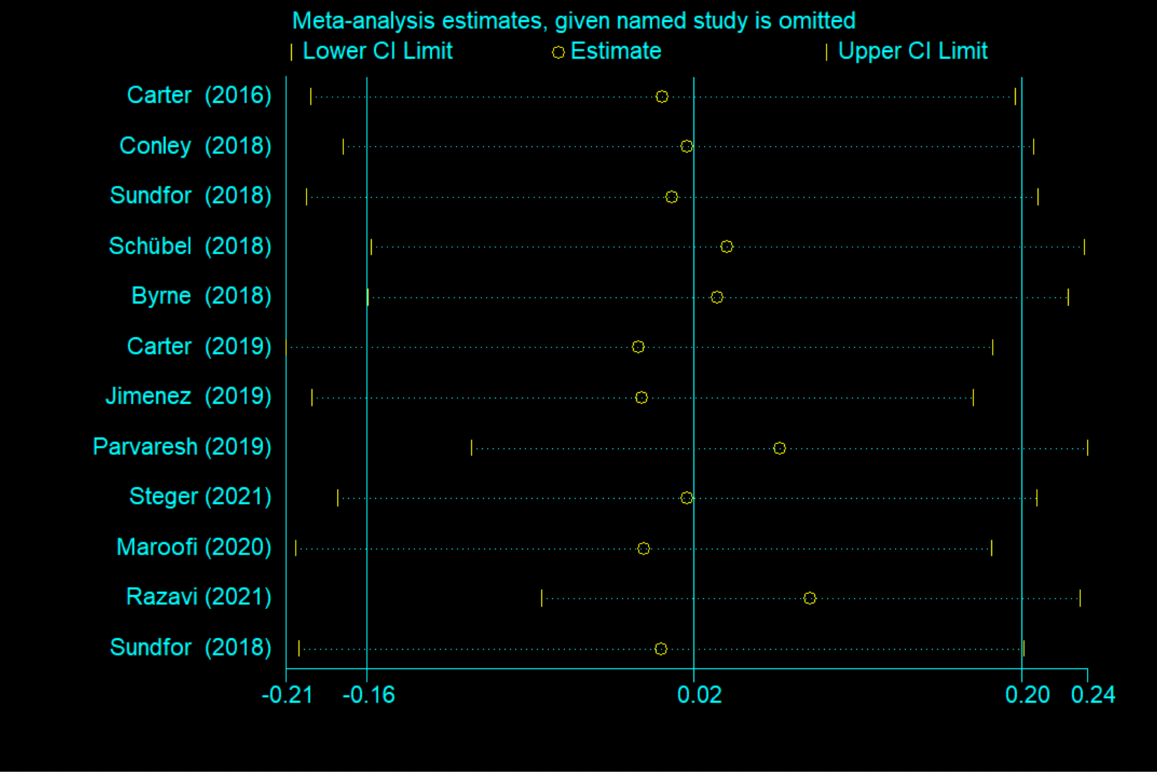
Figure 13. Impact analysis of a single study based on BMI.